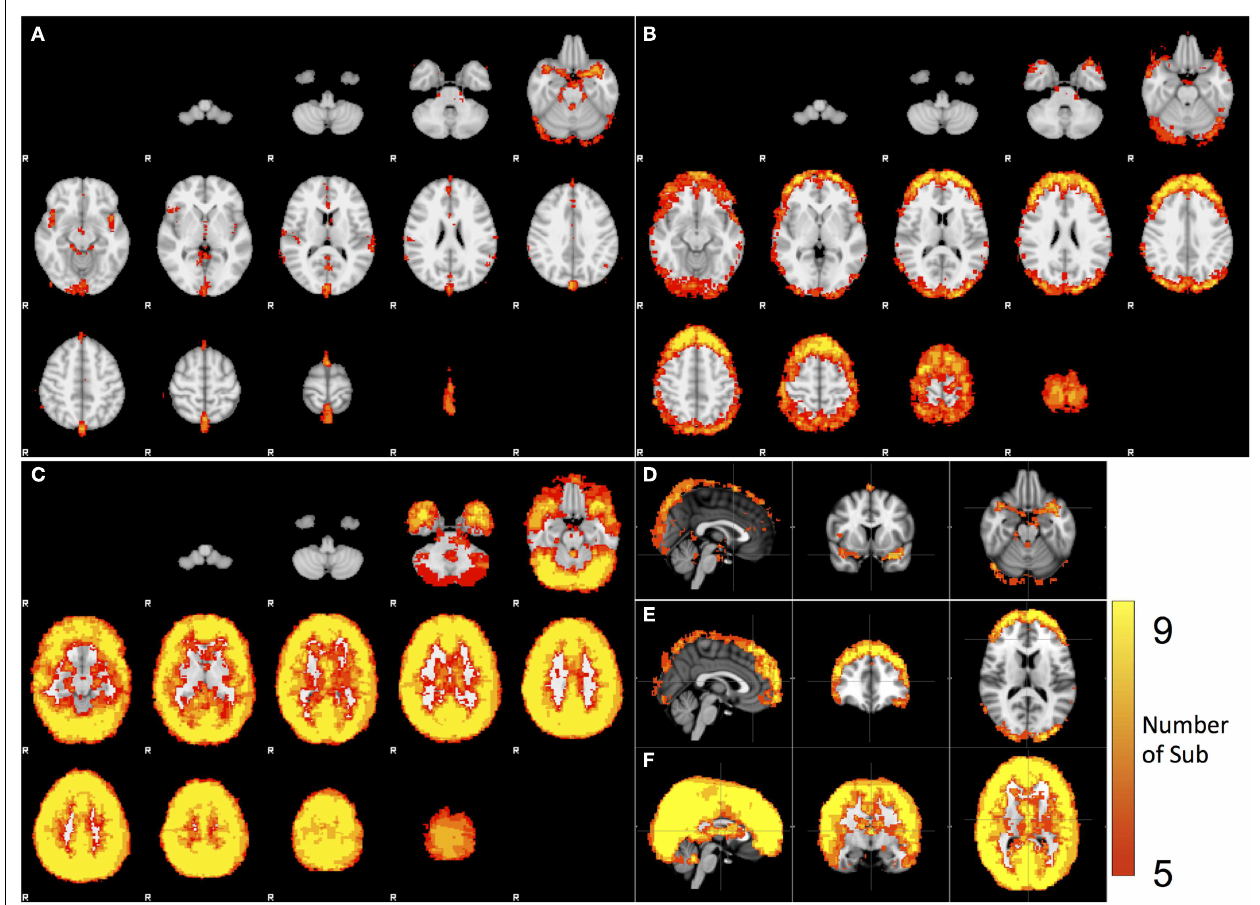
FIGURE 3 | Spatial distribution of the voxels that have significant spectral content in the following bands: (A) cardiac pulsation, (B) respiration, and (C) LFO .The orthogonal views of (A,B,C) are shown in (D,E,F) .